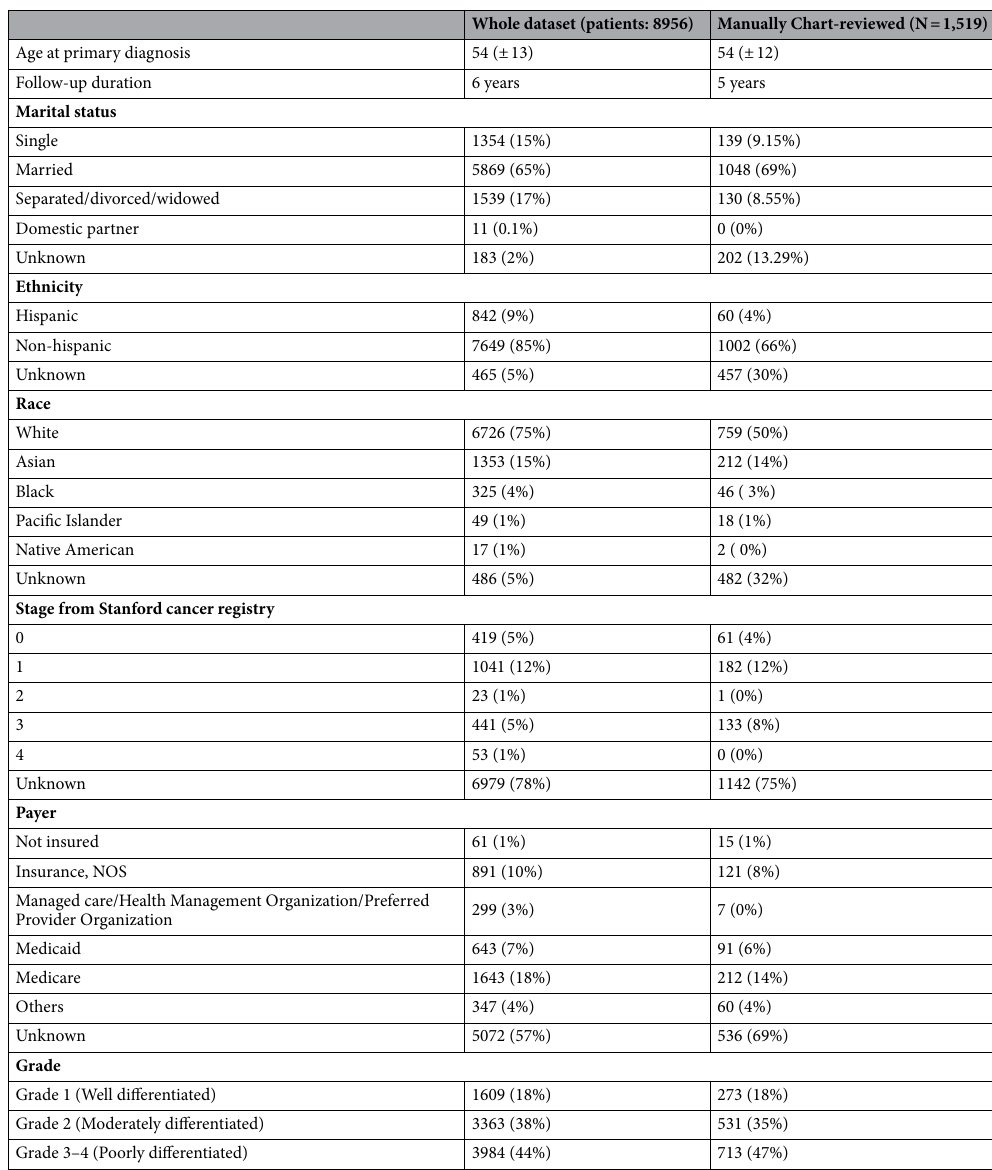
Table 3. Characteristics of the Oncoshare patients: overall and manually curated